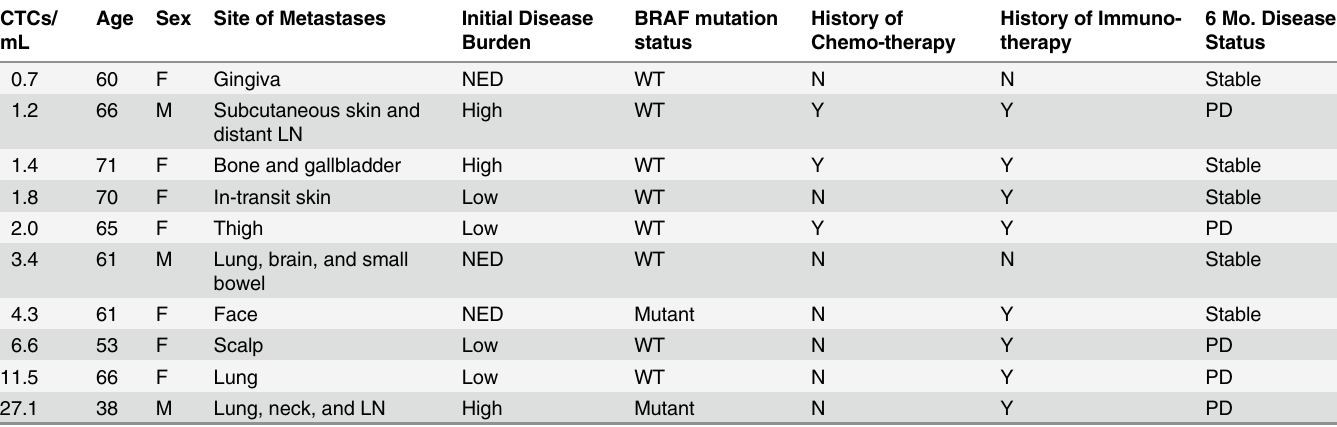
Table 1. Pilot study patient demographics, disease course characteristics at time of the CTC analysis. CTCs/